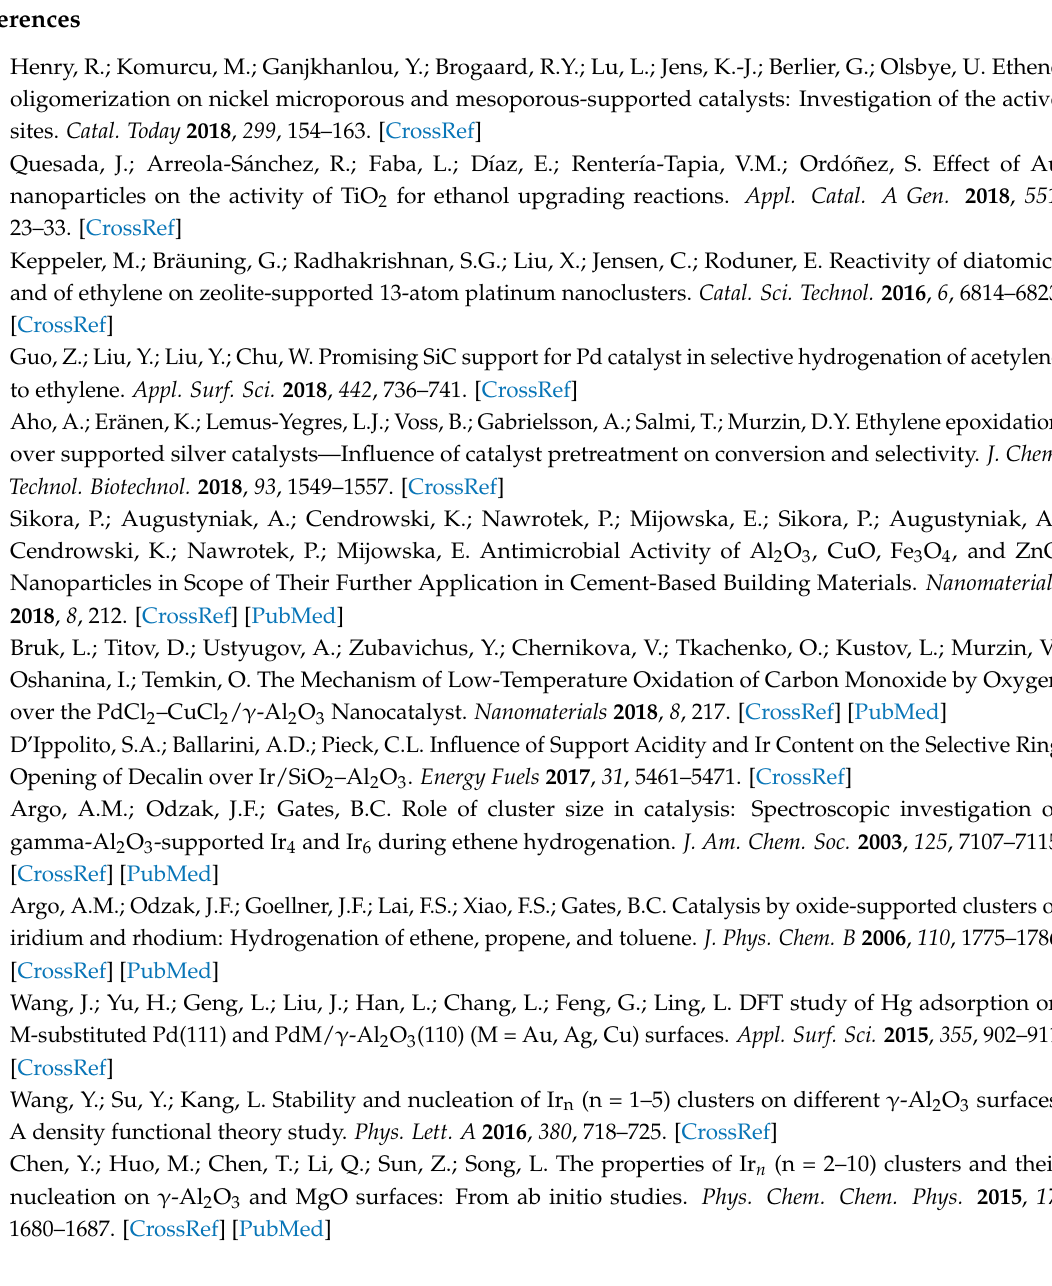
Figure S1: M configuration of ethylene adsorption. Figure S2: Linear fitting of ethylene deformation energy E def (C 2 H 4 ) (eV) and mean hybridization value of the carbon center in adsorbed ethylene. Table S1: Geometry, magnetic moment ( M ), and energy of gas phase Ir n (n = 2–10) Table S2: Adsorption energy E ads (eV) and Nucleation energy E nuc (eV) for Ir n clusters on γ -Al 2 O 3